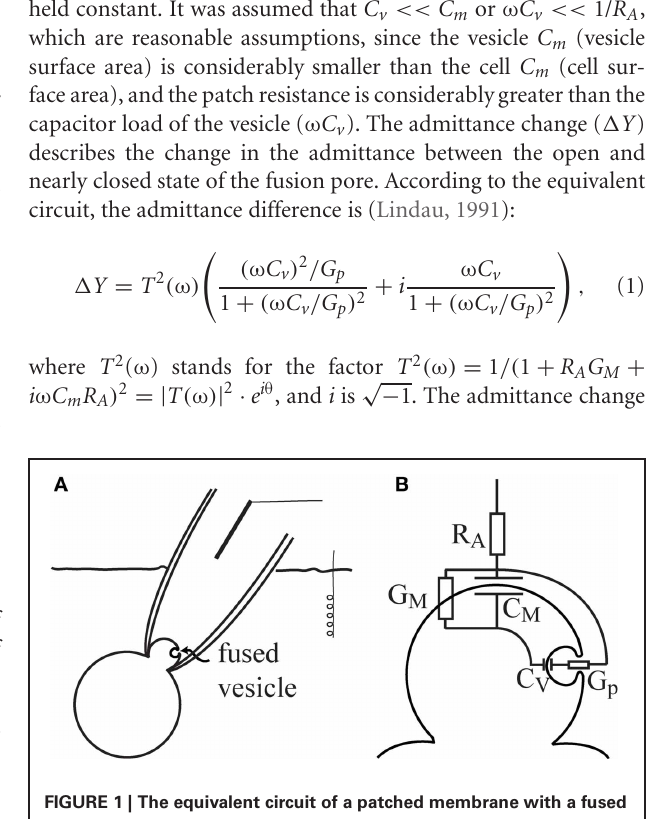
FIGURE 1 | The equivalent circuit of a patched membrane with a fused vesicle. The cell-attached patch-clamp configuration enables the detection of vesicle fusion in the patched membrane region (A) . In the equivalent circuit, the fusion of a vesicle is considered in parallel to the patch membrane (B) . Note that R A is the access resistance, C m is the whole-cell membrane capacitance, G M is the membrane conductance, C v is the vesicle membrane capacitance, and G p is the fusion-pore